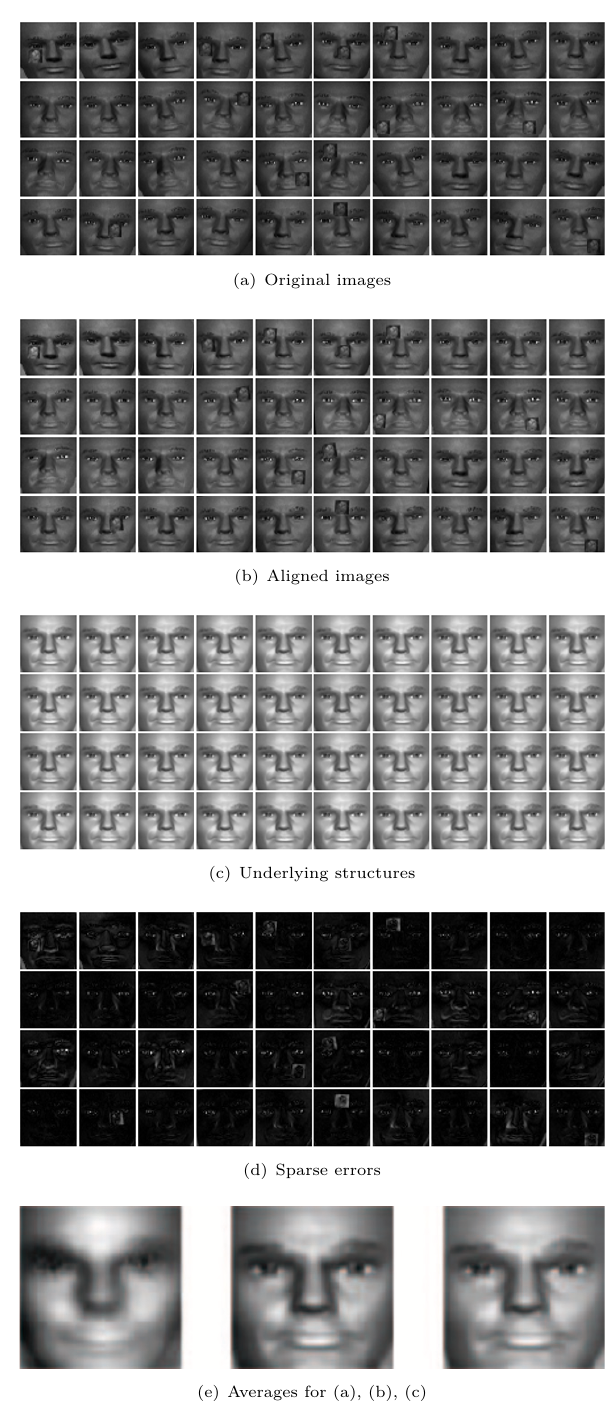
Fig. 2 Representative result with a batch of images of a dummy head. (a) Original unaligned images with partial corruption and occlusion, D